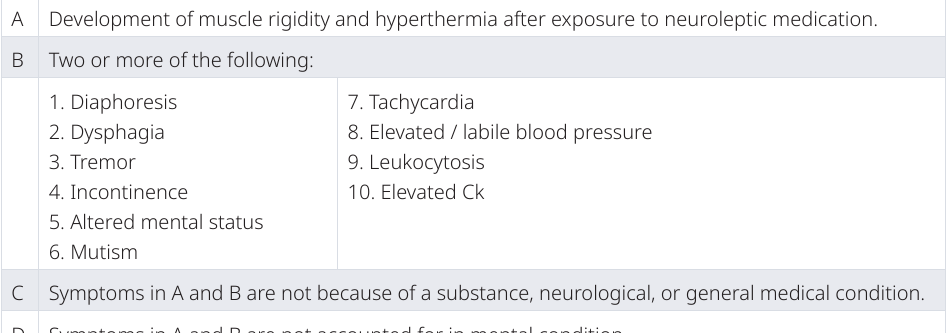
Table 2. Diagnostic and Statistical Manual of Mental Disorders-IV criteria for diagnosis of neuroleptic malignant syndrome. A Development of muscle rigidity and hyperthermia after exposure to neuroleptic